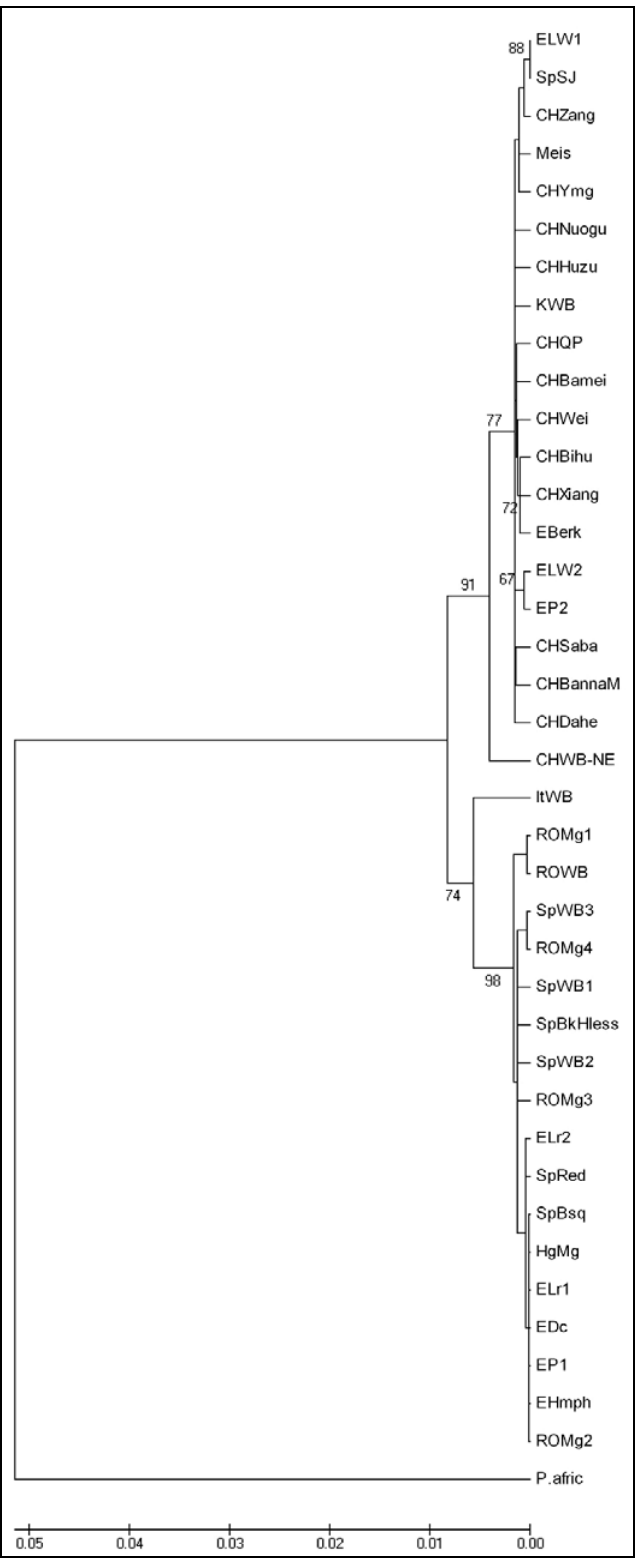
Figure 4. Neighbor-Joining tree based on D-loop and cytochrome b sequences. Figures on the internodes are bootstrap probabilities based on 1000 replications. Outgroup: Phacochoerus africanus